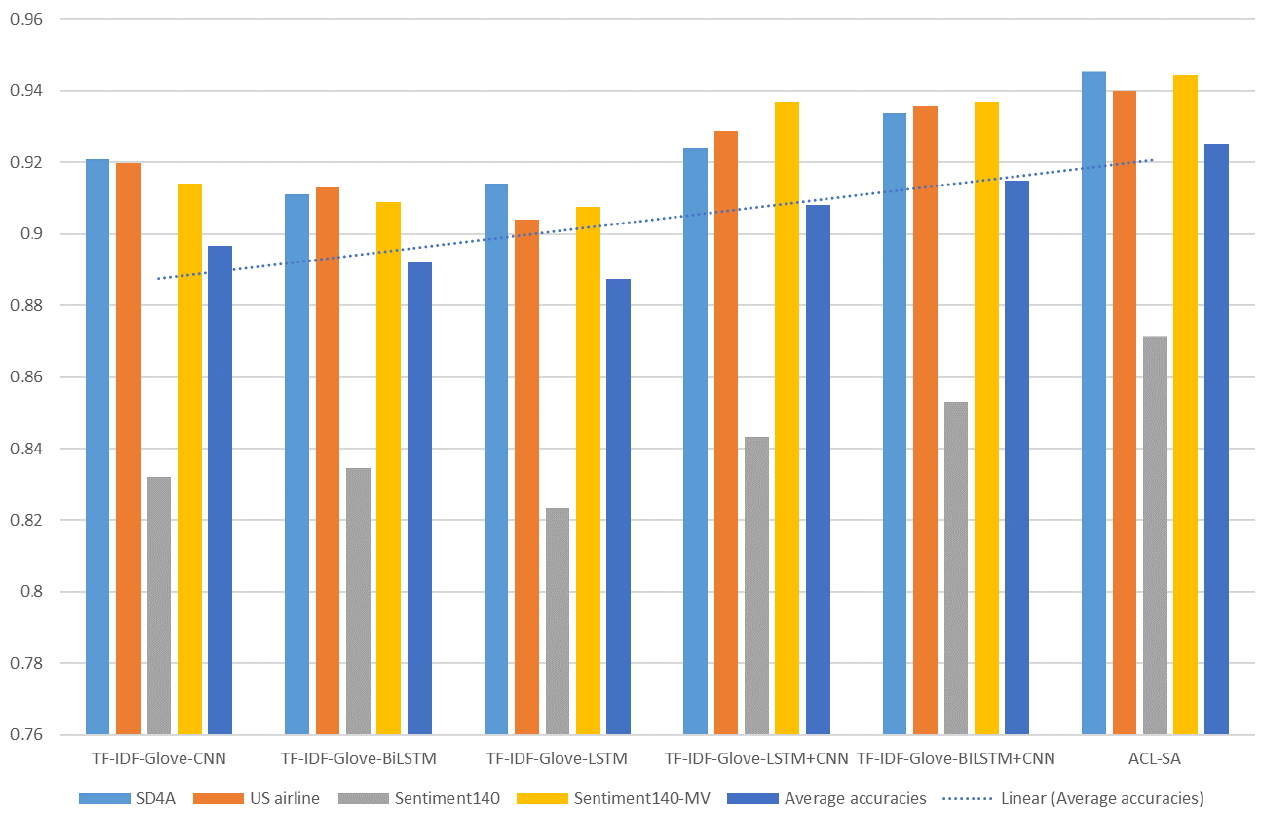
Figure 2. Comparative analysis of the proposed model and model variation on different